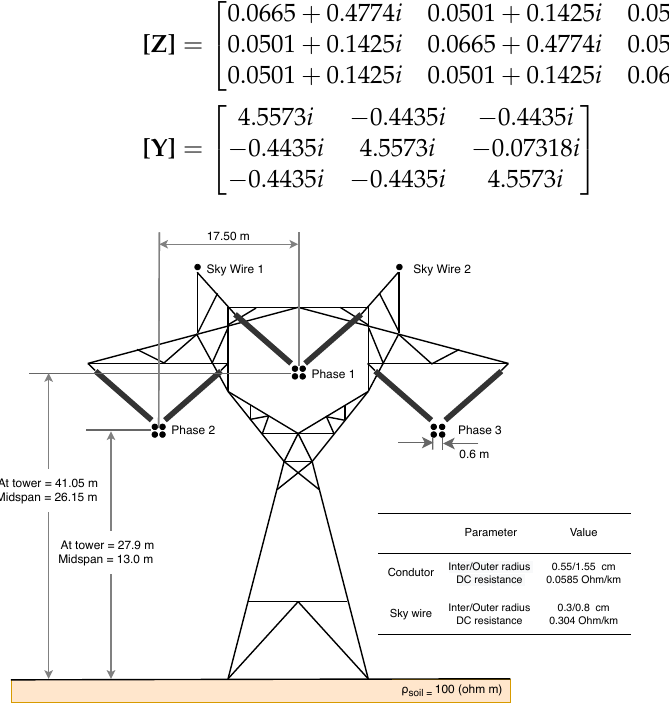
Figure 12. Configuration of the three-phase